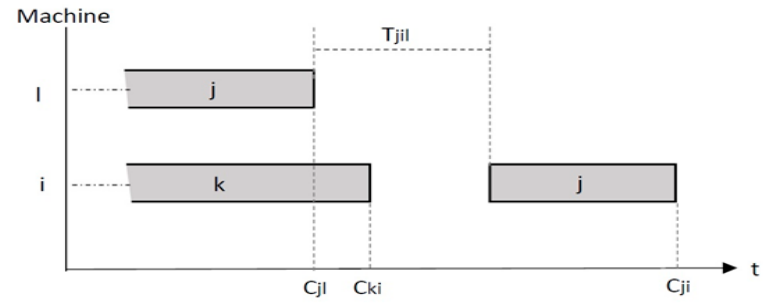
Figure 5. The output of constraint set 9 is acting, 𝐶 (cid:3037)(cid:3036) + 𝑇 (cid:3037)(cid:3036)(cid:3039) > 𝐶 (cid:3038)(cid:3036) .